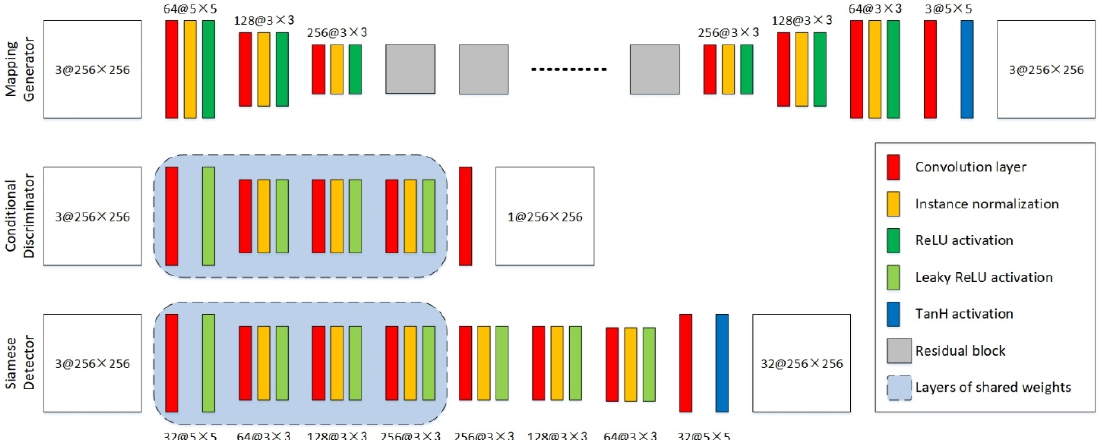
Figure 4. Architectures of mapping generator, conditional discriminator, and Siamese detector.